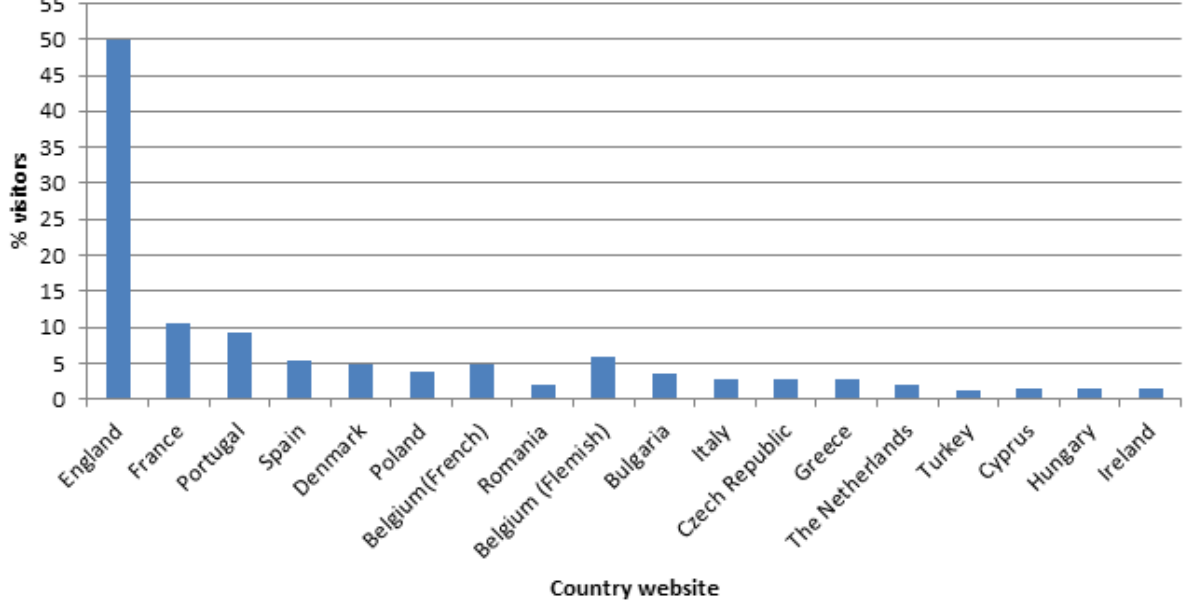
Figure 1. The proportion of visitors to each country's e-Bug website between September 2010 and August